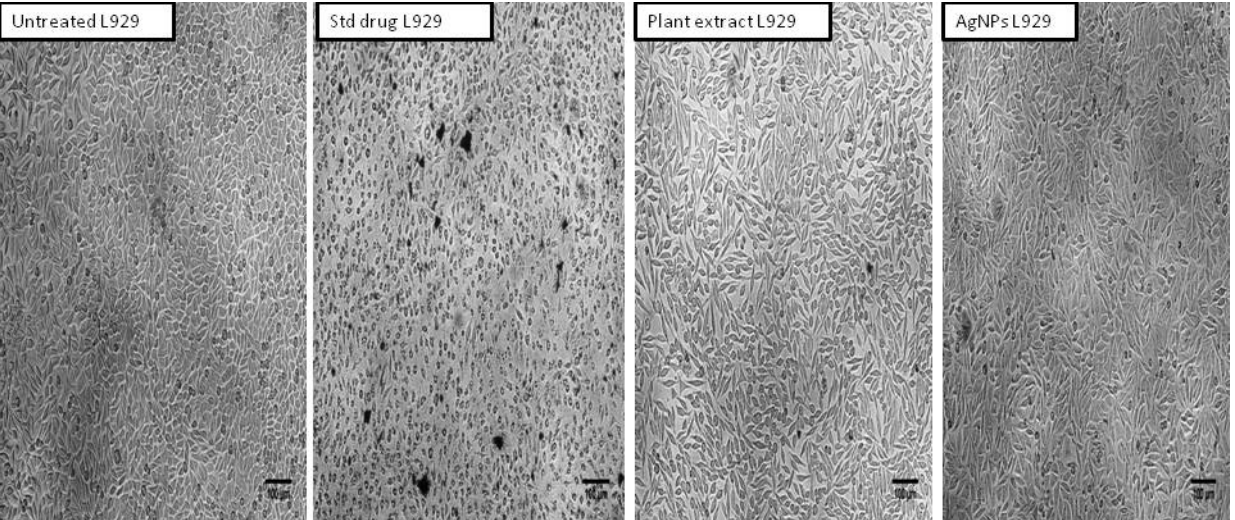
Figure 10. Morphological changes in L929 after treatment with aqueous leaf extract of R. apiculata and AgNPs. Table 7. Cytotoxicity of aqueous leaf extract of R. apiculata and its synthesized AgNPs against L929 cell line.